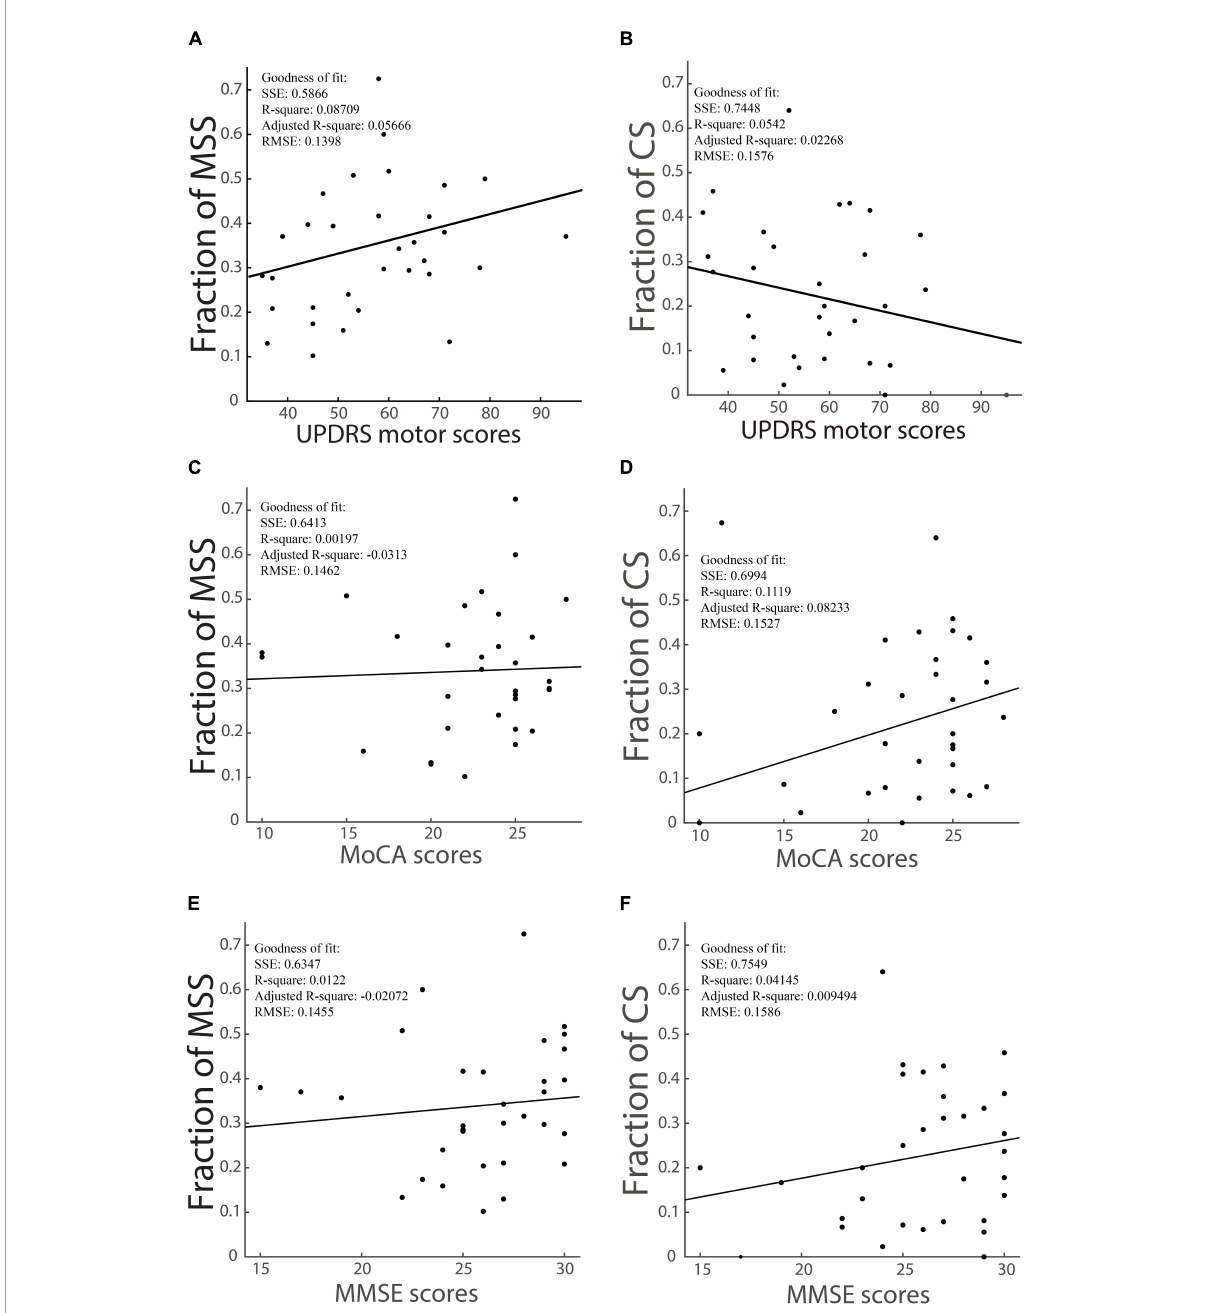
FIGURE3 The correlation between the incidence of MSS, the incidence of CS and the UPDRS motor scores, scores of cognitive tests of PD patients. The incidence of MSS is modestly and positively correlated with UPDRS motor scores, as shown in panel (A) , while the incidence of CS has a slightly negative correlation with UPDRS motor scores, as shown in panel (B) . The incidence of MSS is not correlated with MoCA (C) and MMSE (E) scores, while the incidence of CS has a modestly positive correlation with MoCA (D) and MMSE (F) scores. SSE, the sum of squares due to error; RMSE, the root mean squared error; R-square, the coefficient of determination; Adjusted R-square, the degrees-of-freedom adjusted coefficient of determination.